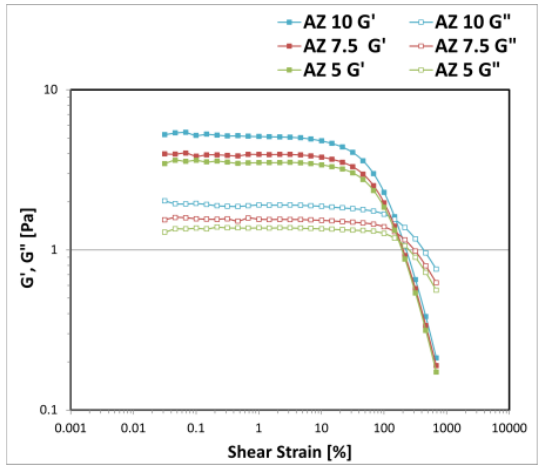
Figure 8. Storage G’ and loss G’’ moduli trend as a function of the oscillation strain measured for